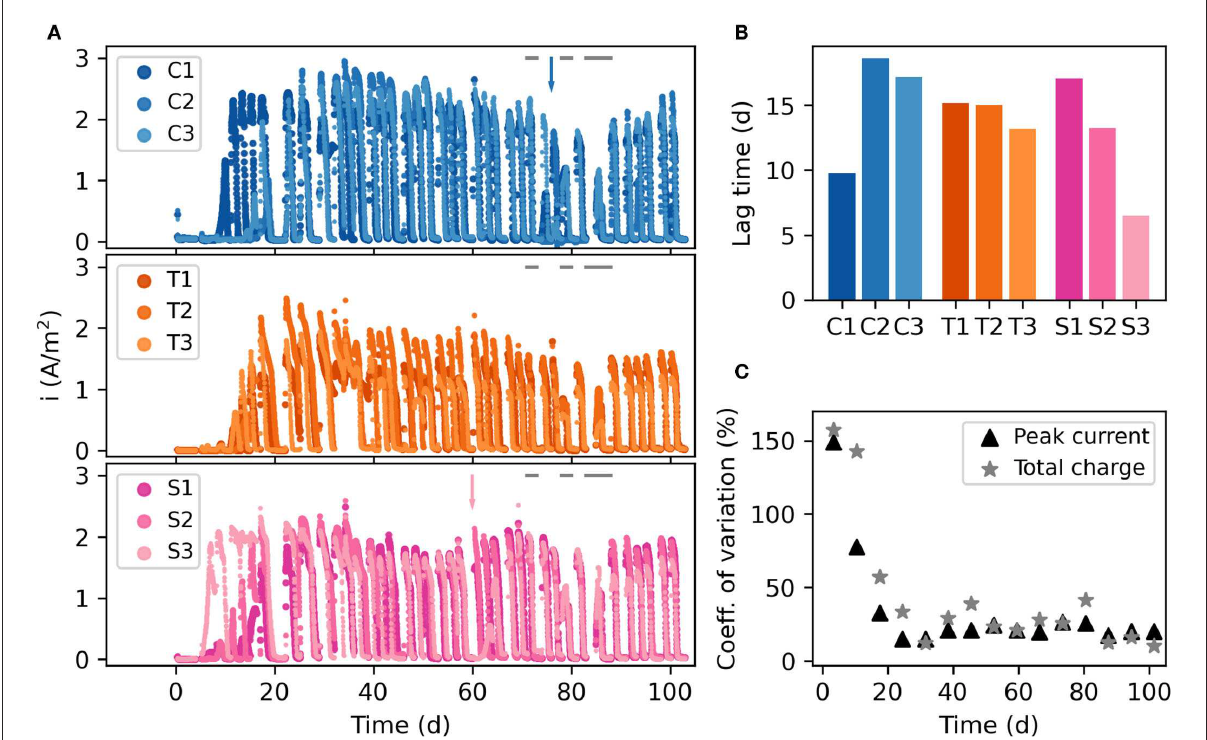
FIGURE2 (A) Current density throughout the experimental run. The gap around day 85 is when the three-day experiment with no current was performed. C1–C3 are the carbon nanoparticle reactors, T1–T3 are the titanium reactors, and S1–S3 are the steel reactors. The arrows show when foaming incidents occurred in C2 and S3. The gray bars at the top of the panels show when specific tests with individual carbon sources were carried out. (B) Lag time before each MEC started producing current. (C) Variation in peak current and total charge per week for all 9